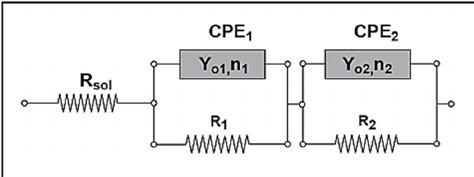
Figure 10. Electrical equivalent circuit model simulating a corroding system metal/coating/electrolyte, R s = solution resistance, R 1 , R 2 = ohmic resistances, CPE 1 , CPE 2 = constant phase elements with admittance Y 0 ( j ω ) n .